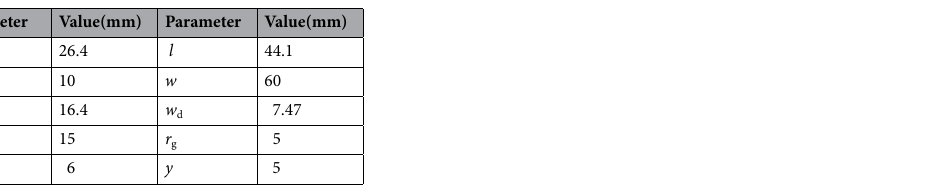
Table 1. Main parameter of the proposed notch band antenna.